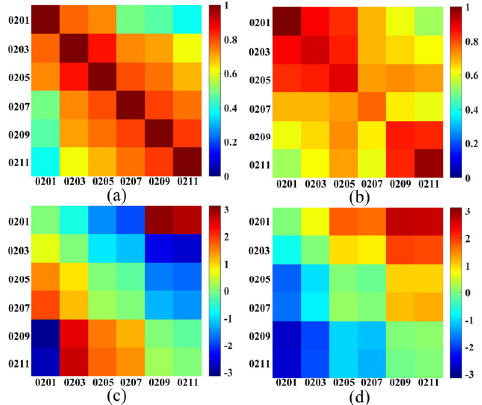
Figure 9. Comparison of the amplitude and phase of the CM for the different methods: ( a ), ( c ) are, respectively, the amplitude and phase of the CM of the LM method; and ( b ), ( d ) are, respectively, the amplitude and phase of the CM of the NLM method.